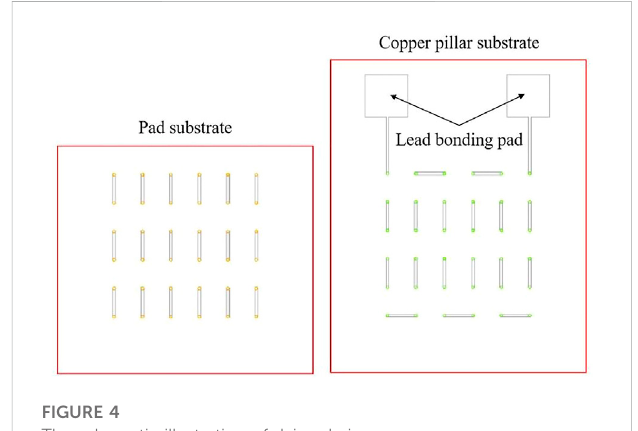
FIGURE 4 The schematic illustration of daisy